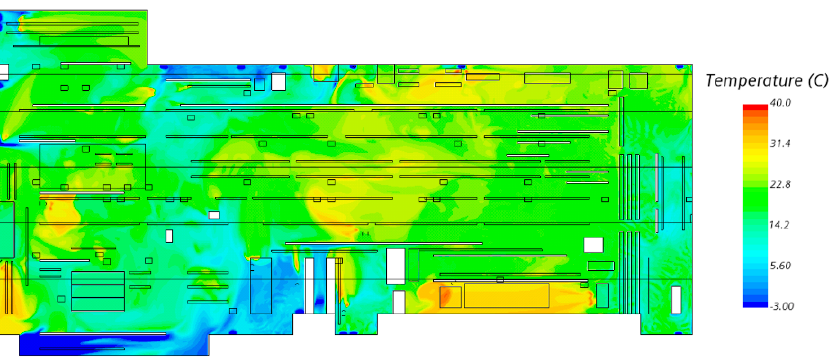
Figure 10. Heating performance on the revised condition (strategy 2) of inflow rates of outside air.